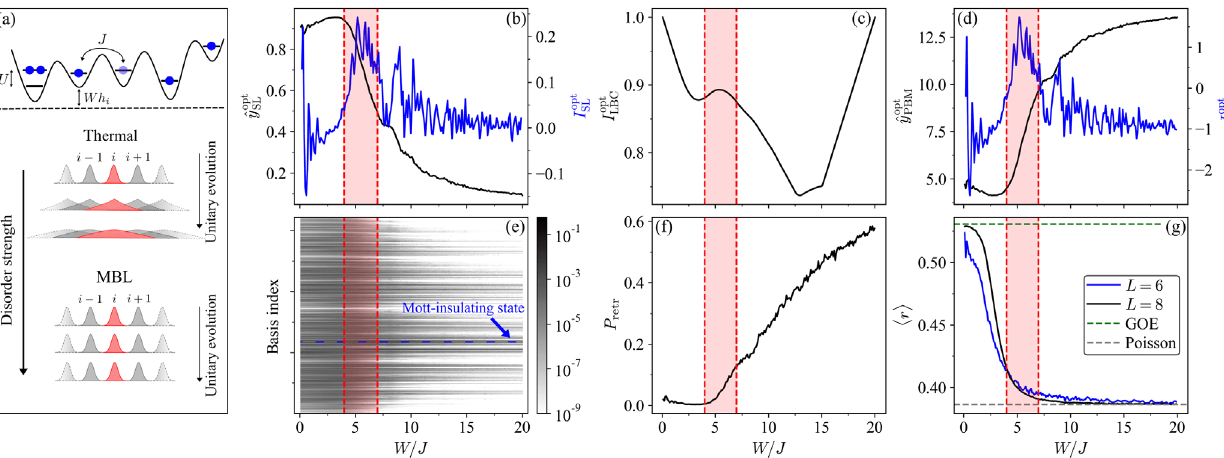
FIG. 8. Results for the MBL phase transition in the 1D Bose-Hubbard model ( L ¼ 8 ) with the dimensionless disorder strength as a 20 in steps of Δ p ¼ 0 . 1 . Here, 1 . 1 × 10 3 different disorder realizations are tuning parameter p ¼ W=J ranging from p 1 ¼ 0 . 1 to p K ¼ 1 and l K . The reference range for the critical considered. In SL, the data obtained at p 1 and p constitute our training set, i.e., r K I ¼ II ¼ =J ≈ 4 – 7 [10,76] at which the phase transition between the thermalizing and MBL phase occurs is value of the tuning parameter W c highlighted in red. (a) Illustration of the 1D Bose-Hubbard model [Eq. (40)] (top) and the MBL phase transition (bottom), where the in SL (black line) and the corresponding indicator I opt system is initialized in a Mott-insulating state. (b) Mean optimal prediction ˆ y opt SL SL (blue line). (c) Optimal indicator of LBC I opt (black line). (d) Mean optimal prediction ˆ y opt in PBM (black line) and the corresponding PBM LBC 8 particles) as a (blue line). (e) Probability distributions governing the input data (indices of Fock basis states with N indicator I opt b ¼ PBM function of the tuning parameter, where the color scale denotes the probability. The color scale is cut off at 10 − 9 to improve visual clarity. The blue dashed line highlights the initial Mott-insulating state. (f) Disorder-averaged retrieval probability P as a function of the retr tuning parameter corresponding to the line cut marked in (e). (g) Average ratio of consecutive level spacings h r i for a chain of length 0 . 5307 (green dashed line) and r 2 ln ð 2 Þ − 1 ≈ 0 . 3863 L ¼ 6 (blue line) and L ¼ 8 (black line) with reference values r GOE ¼ Poisson ¼ (gray dashed line). We consider all eigenstates located in the middle one-third of the spectrum [76,103] restricted to subspace with N L particles and additionally average over multiple disorder realizations ( 1 × 10 4 for L ¼ 6 and 1 . 1 × 10 3 for L ¼ 8 b ¼